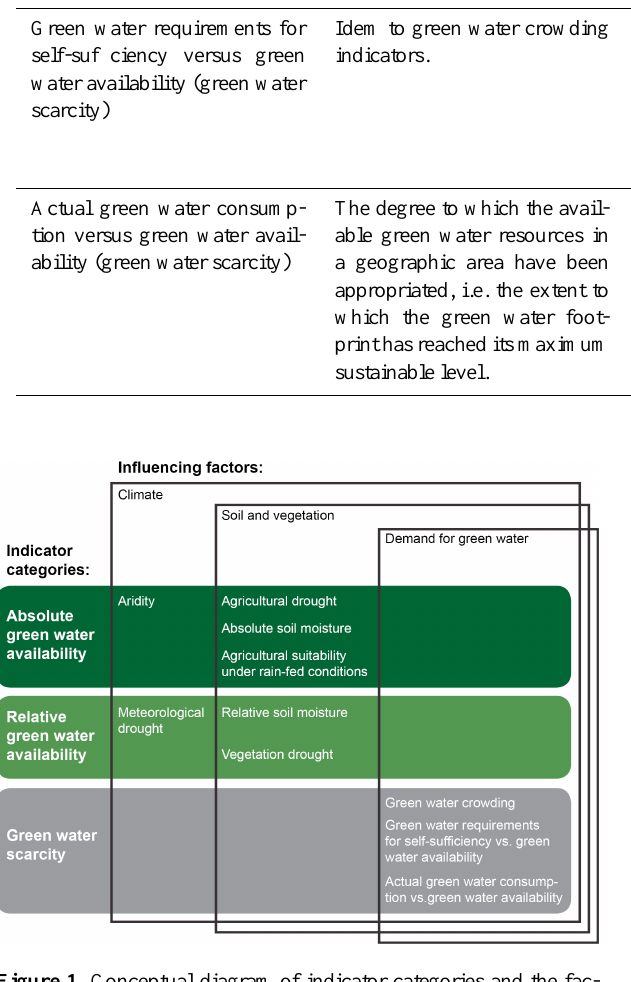
Figure 1. Conceptual diagram of indicator categories and the fac- tors that influence